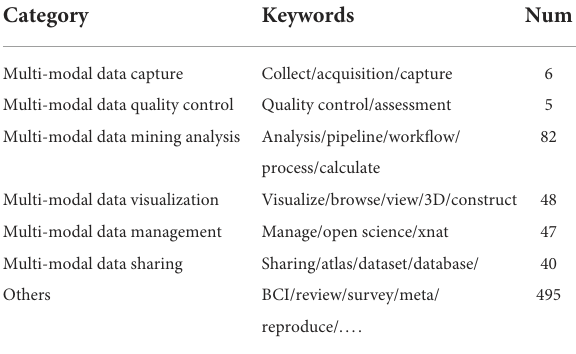
TABLE 1 The categories of all articles published in Frontiers in